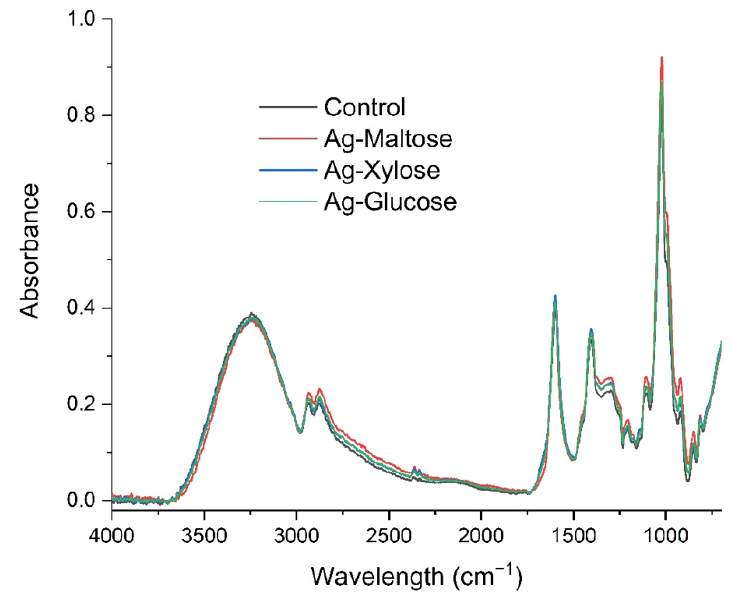
Figure 4. FTIR absorption spectra of control (black line), Ag-xylose (blue line), Ag-maltose (red line) and Ag-glucose (green line) .